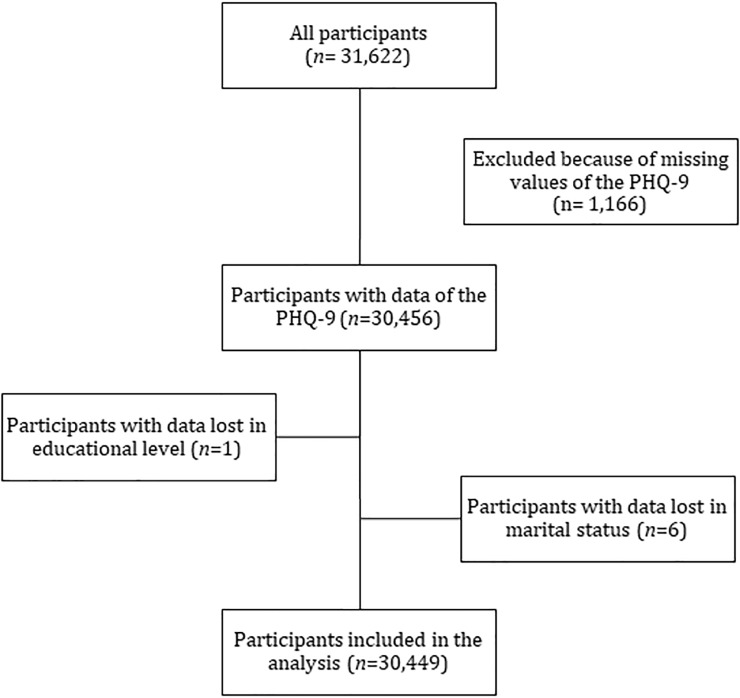
Flowchart of selected participants included in the study.